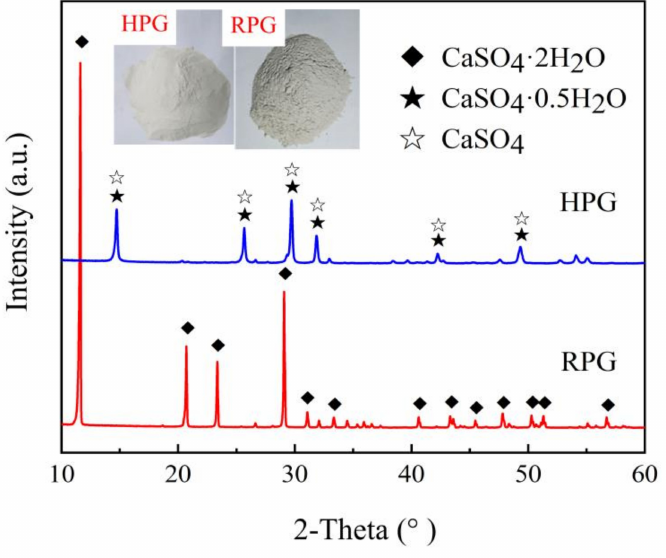
Figure 1. XRD spectra of raw materials RPG and HPG.